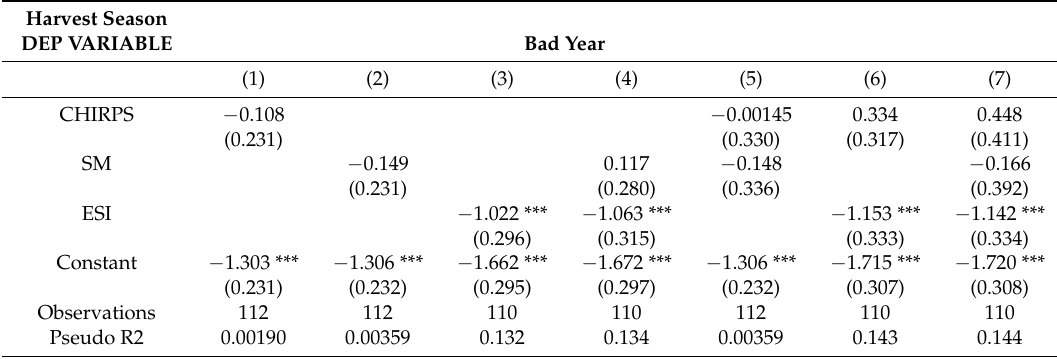
Table 6. Logit regression results focusing on maize-harvesting months for rainfall (Column 1), soil moisture (Column 2), ESI (Column 3), soil moisture and ESI (Column 4), rainfall and soil moisture (Column 5), rainfall and ESI (Column 6) and all variables combined (Column 7); “bad years” are the dependent variable; rows represent the regression coefficient for the three independent variables (rainfall, soil moisture, ESI), the regression constant, the number of observations, the pseudo R-squared and the number of countries (8); asterisks mark statistically significant